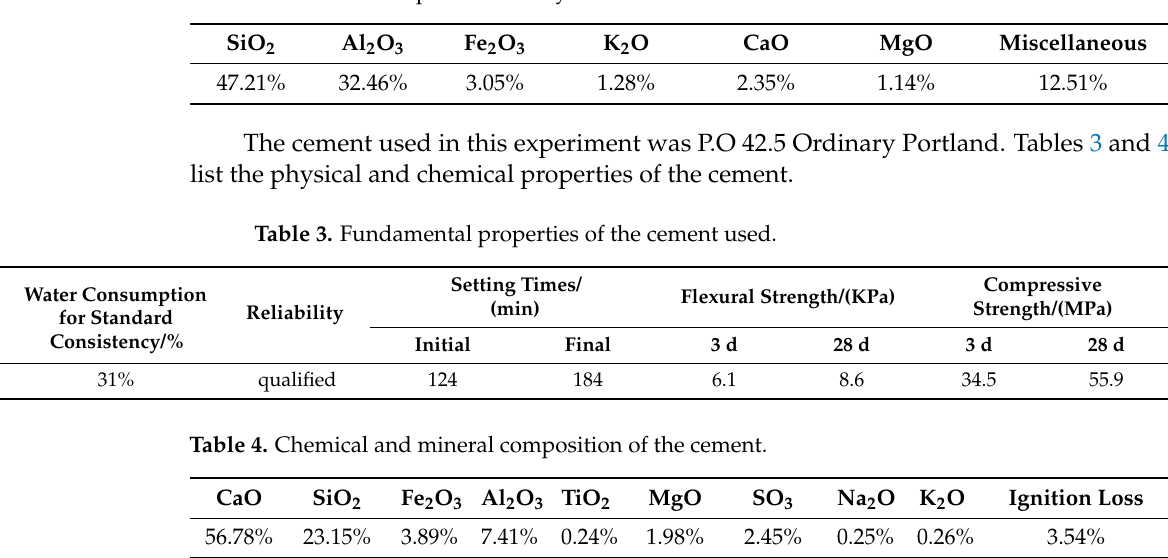
Table 2. Chemical composition of clay.